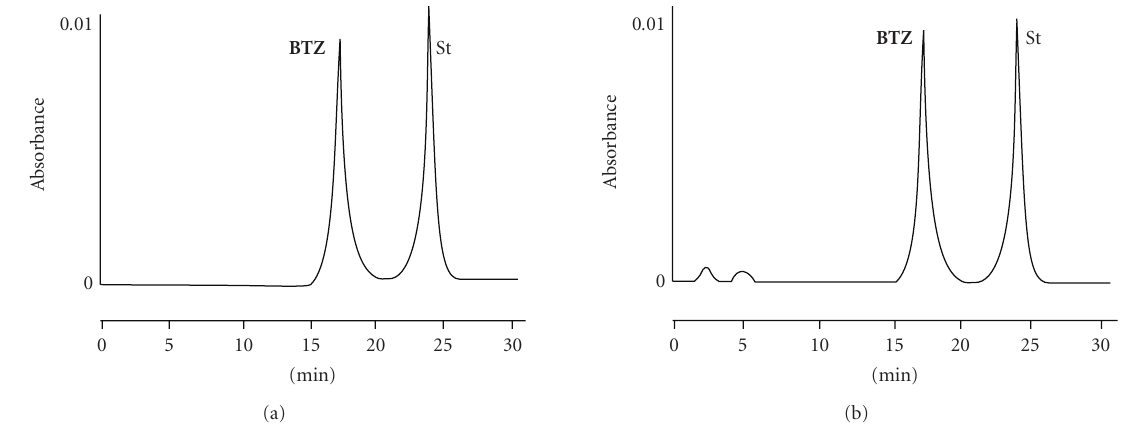
Figure 6: HPLC analysis of bortezomib solutions A, B, and C kept in dark at 4 ◦ C for a week. (a) No degradation product was observed. (b) After a month, a small amount of two new products, eluted at 1 and 5 minutes, respectively, was